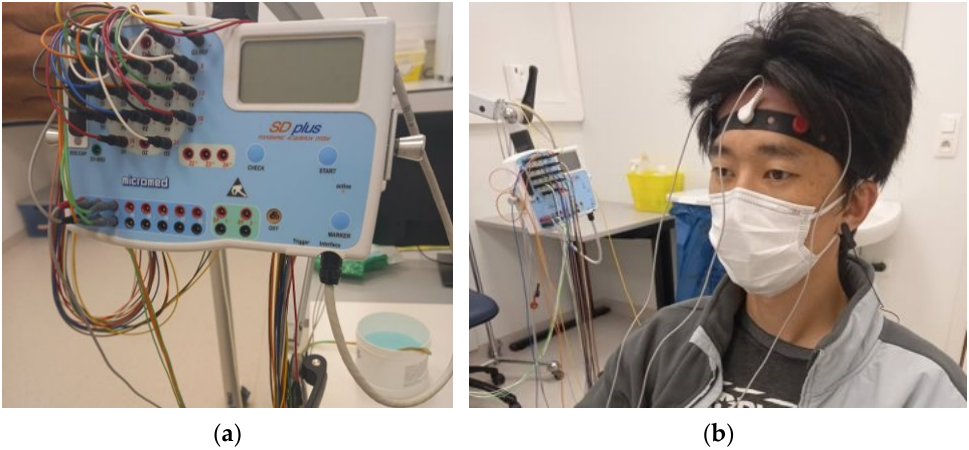
Figure 12. Electroencephalography (EEG) measurement: ( a ) Brain Quick EEG Clinical line and ( b ) photographic image of actual EEG measurement.